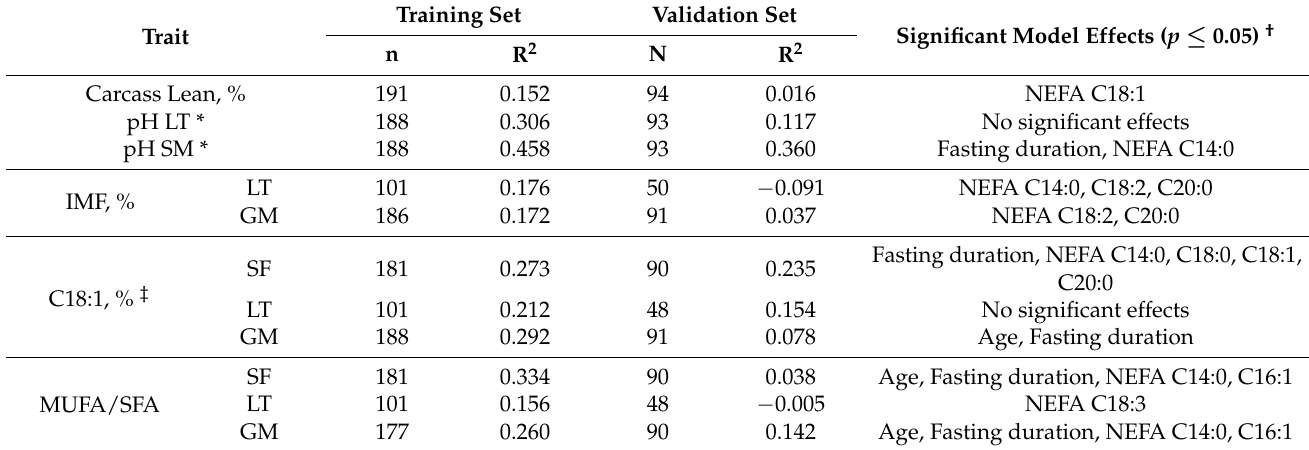
Figure 3. Relationship of the absolute amount of oleic acid in plasma (ng/mL) with intramuscular fat (IMF) in GM and LT by fasting duration. Table 4. Prediction of carcass and meat quality traits using quantitative NEFA composition.